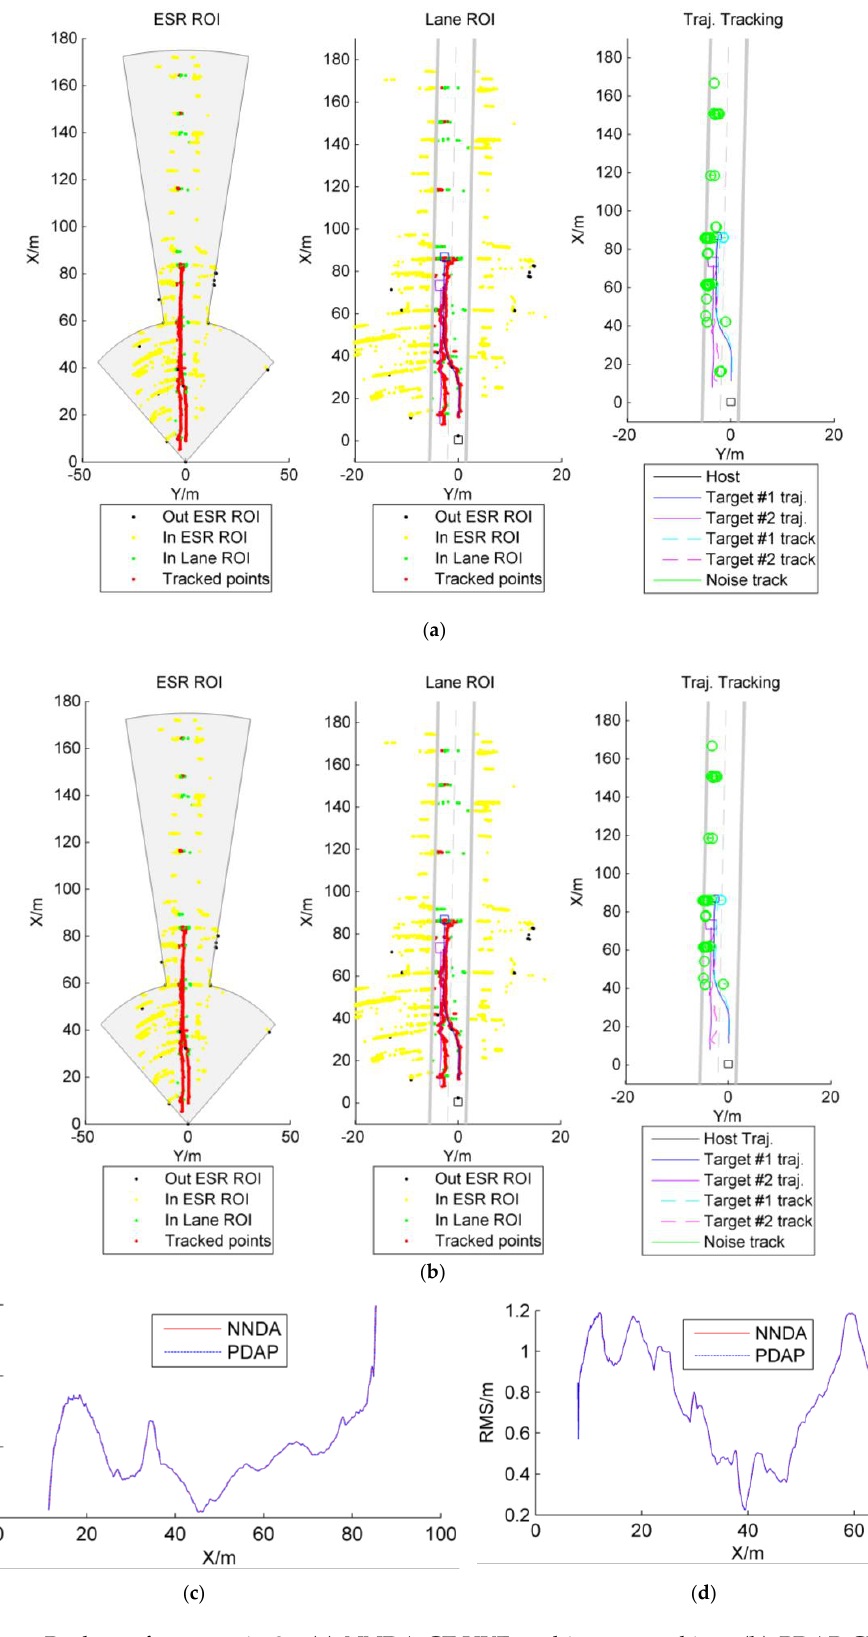
Figure 6. Real test for scenario 2. ( a ) NNDA-CT-UKF multitarget tracking; ( b ) PDAP-CT-UKF multitarget tracking; ( c ) RMS for tracking target #1; ( d ) RMS for tracking target #2.